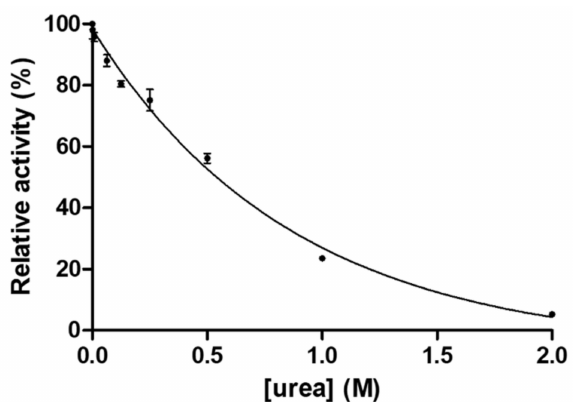
Figure 5. Dependence of GST-SASP14 activity on urea concentration. Enzyme activity was measured at increasing urea concentration. We used HPLC-based detection of substrate cleavage as described in Materials and methods. Error bars represent SD ( n = 2). The UC 50 of GST-SASP14 was found to be lower as compared to HIV-1 PR, but was higher those of Ty1 and XMRV PRs (Table